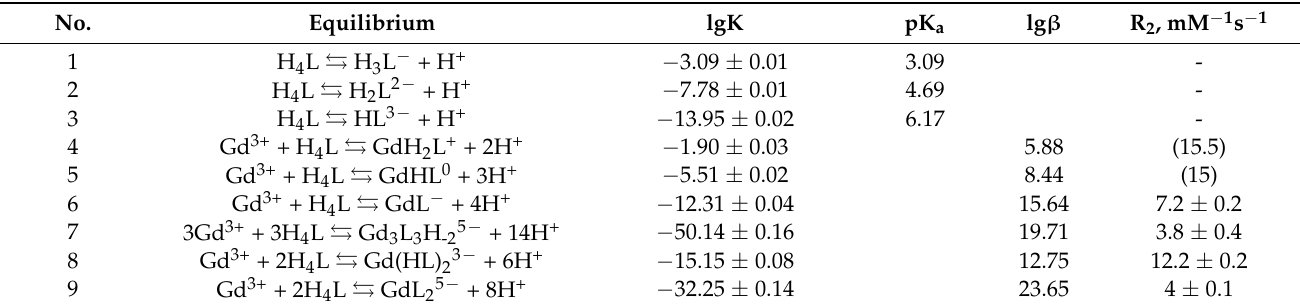
Table 1. Dissociation constants of citric acid, equilibrium constants of formation of citrate complexes of Gd(III), and their stability constants and relaxivity